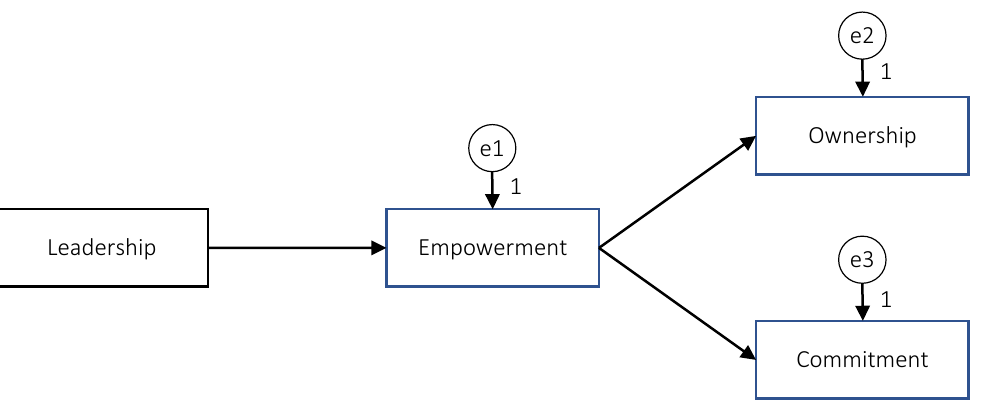
Figure 2. Fully mediated model (M-1)